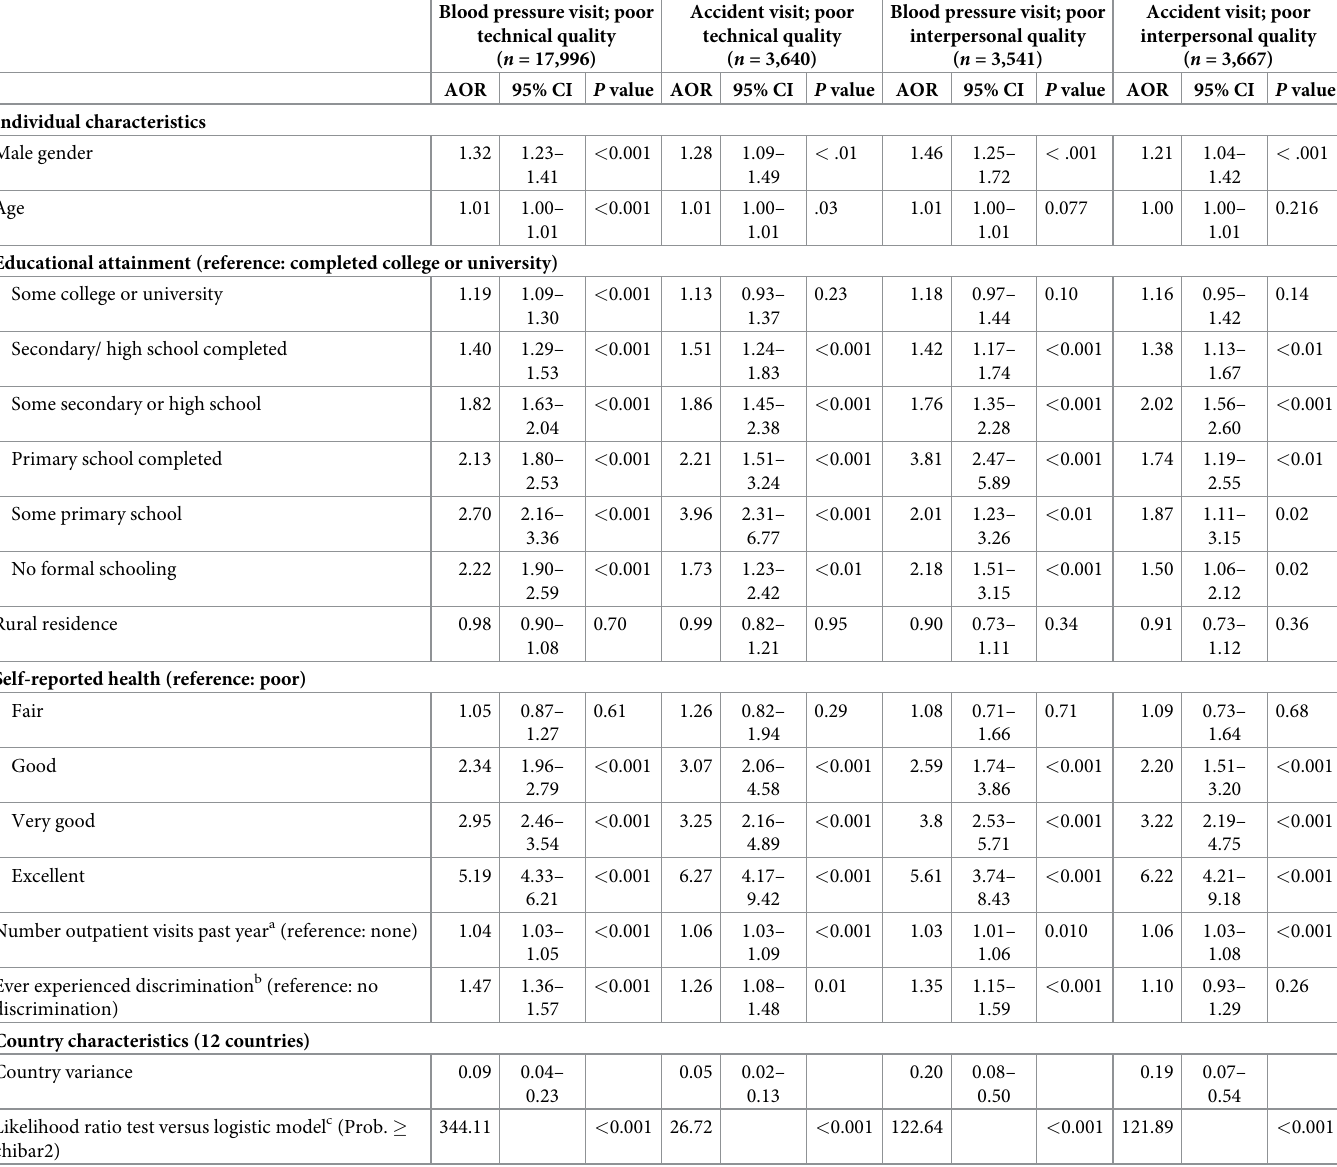
Table 2. Determinants of good ratings of poor